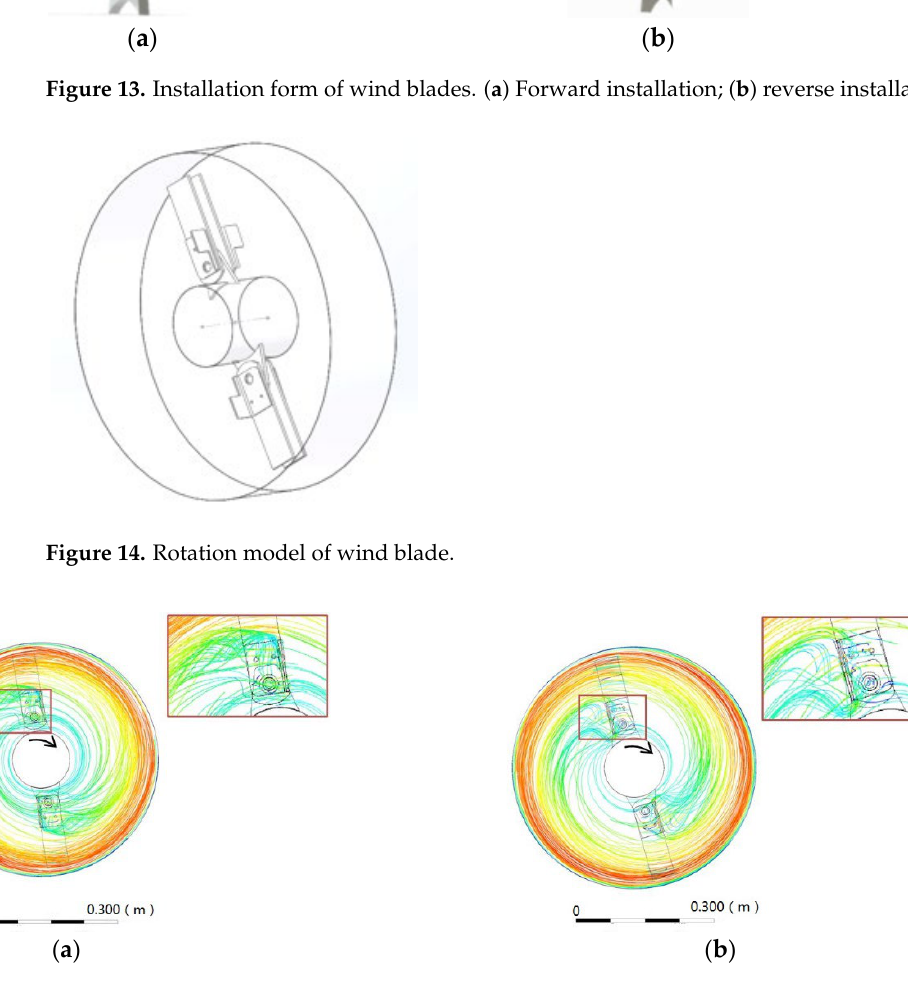
Figure 15. The surrounding airflow cloud diagram when the WB was installed in the forward and reverse directions. ( a ) Forward installation; ( b ) reverse installation.